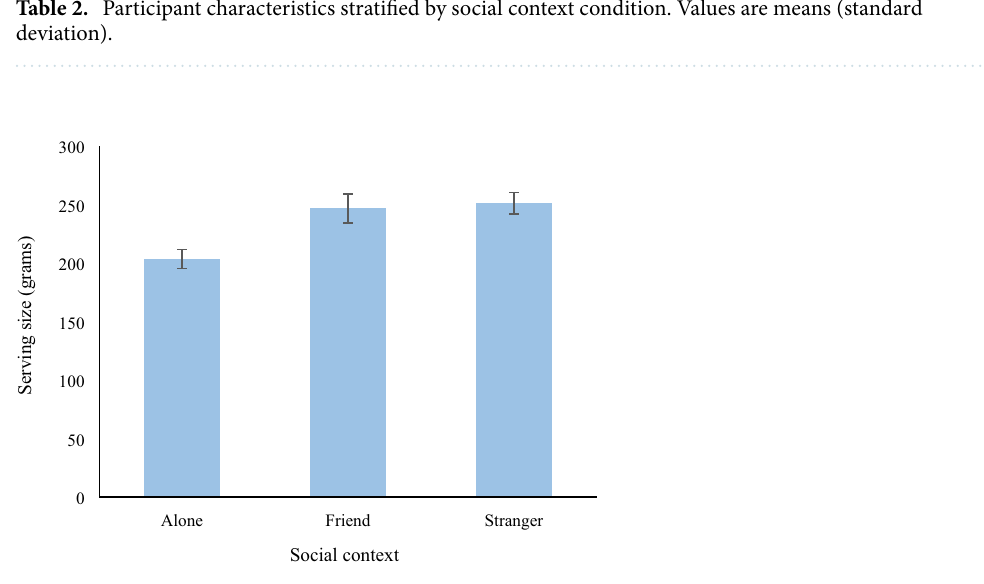
Figure 2. Amount served (grams) as a function of social context condition. Values are means, and error bars represent the standard error of the